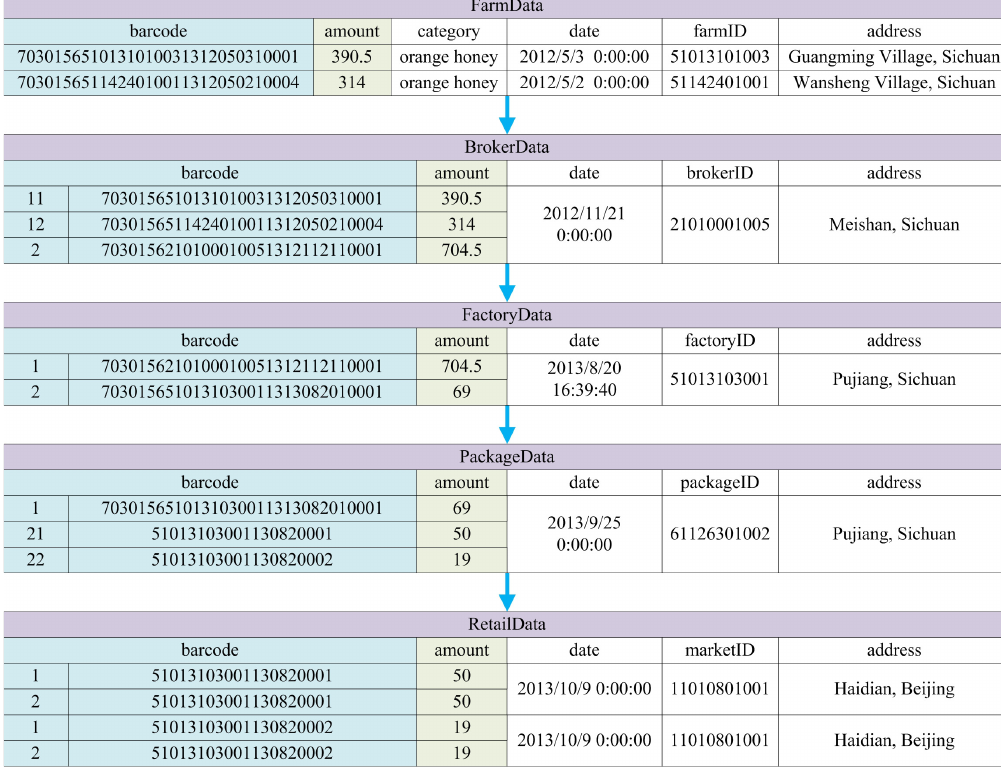
Figure 13. Original data of the manufacturing process of an orange honey